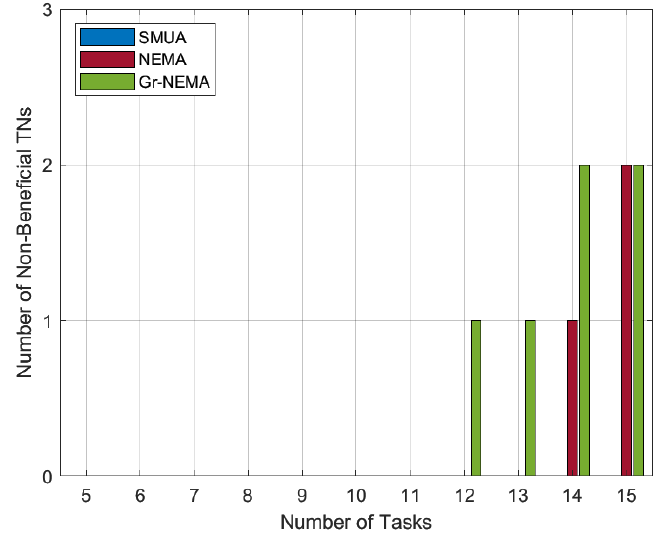
Figure 6. Non-beneficial TN tasks.